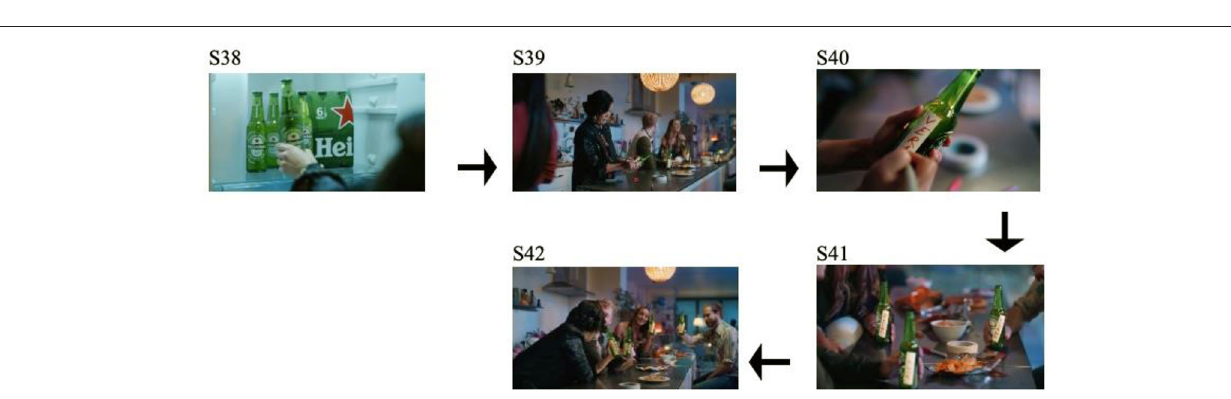
FIGURE 3 | Screenshots of segment 2 from the Heineken video “Home Gatherings”.